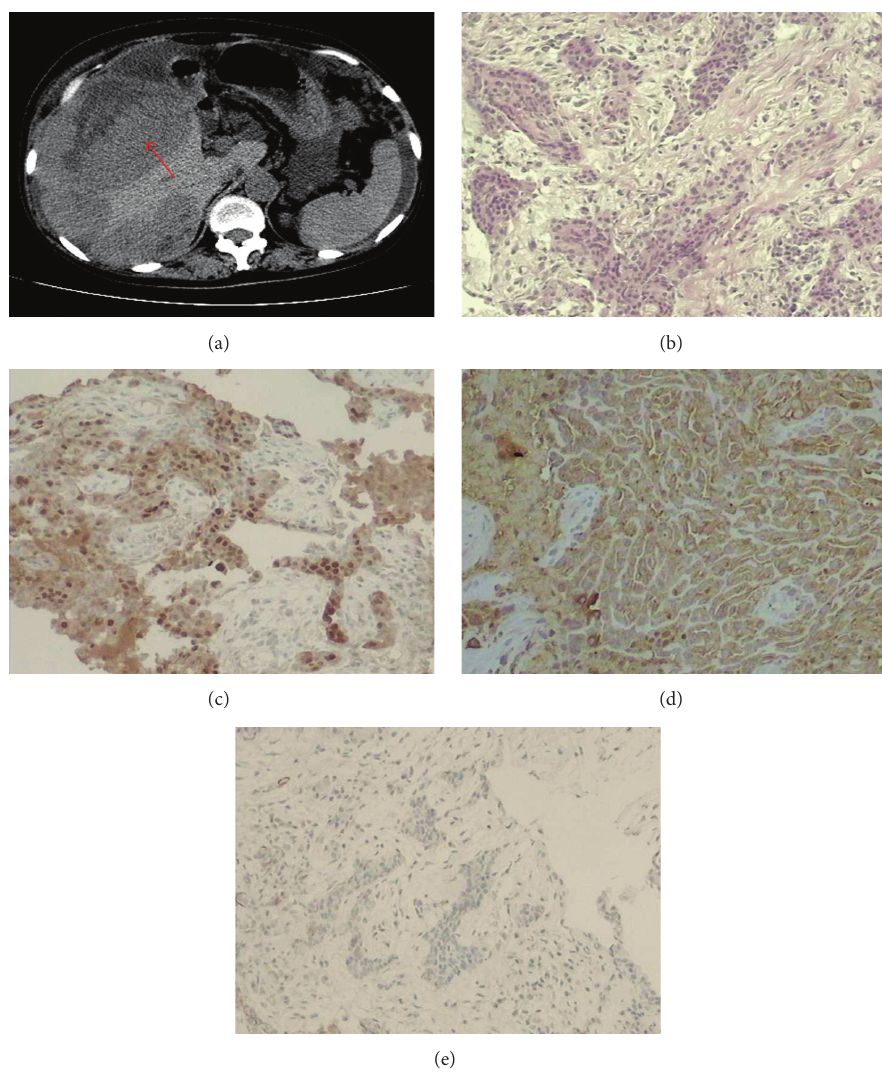
Figure 4: Abdominal CT and cytohistological features on H&E-stained specimens or immunohistochemical stains for case 4. (a) Abdominal CT demonstrated a huge mass with heterogeneous density in the right flank, the peritoneum, and omentum thickening accompanied by multiplemassesinfiltratingtheinferiorpoleof rightliver(redarrows). (b)Cytohistological featuresof theperitoneum biopsyon H&E-stained specimens. Immunohistochemical stains showed that the tumour cells were positive for calretinin (c) and epithelial membrane antigen (d) but negative for carcinoembryonic antigen